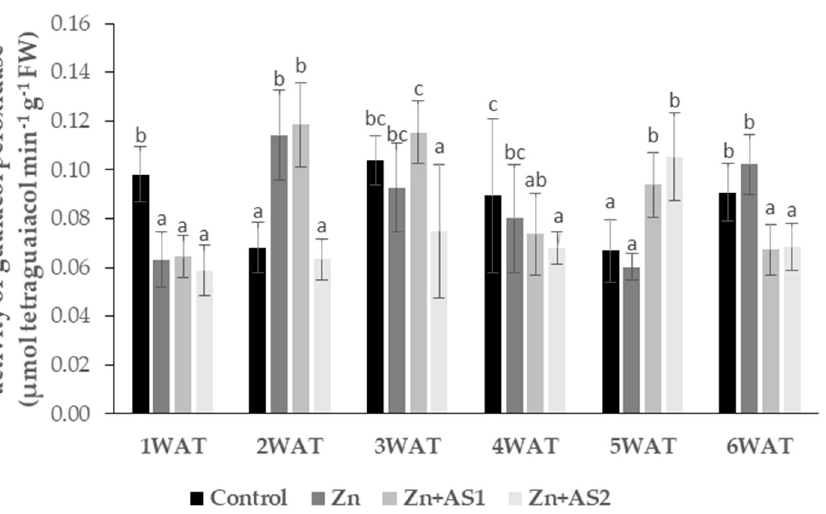
Figure 8. The effect of different foliar treatments (Zn, Zn+AS1, and Zn+AS2) on guaiacol peroxidase activity, n = 12 ± S.D. Lower case letters (a, b, and c) show the significant differences among treatments based on the independent t -test ( p < 0.05). AS: amino acid; FW: fresh weight; Zn: zinc; WAT: week(s) after treatment.